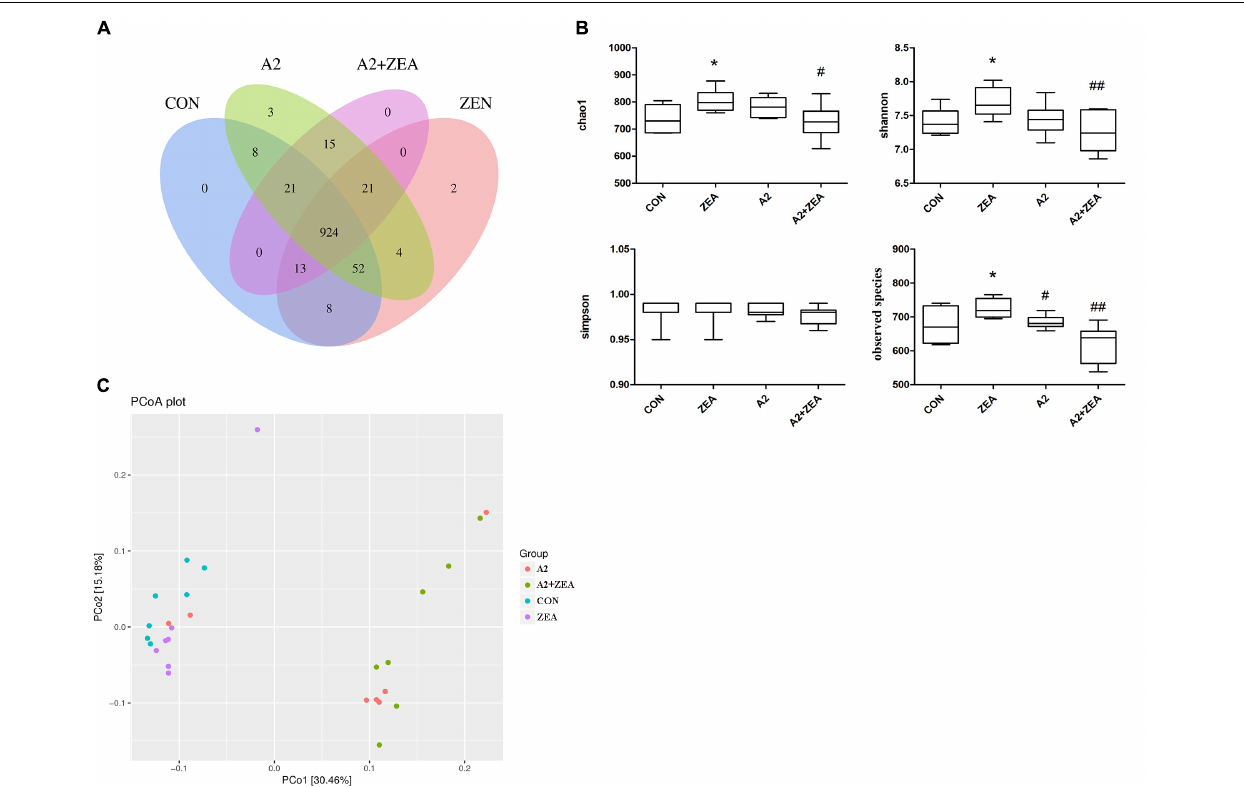
FIGURE 7 | Analysis of the diversity of α and β by OTU distribution map (A) , Chao1, Shannon, Simpson, and observed species (B) represented α diversity. β diversity analysis was described by PCOA chart (C) . "*" means a significant difference compared with the CON group ( P < 0.05). "#" means a significant difference compared with ZEA ( P < 0.05), "##" means an extremely significant difference compared with ZEA ( P < 0.01).